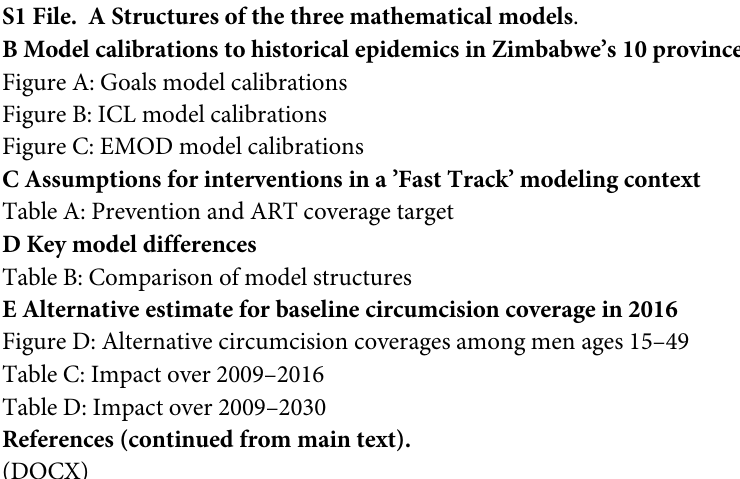
Figure B: ICL model calibrations Figure C: EMOD model calibrations Table A: Prevention and ART coverage target Table B: Comparison of model structures E Alternative estimate for baseline circumcision coverage in 2016 Figure D: Alternative circumcision coverages among men ages 15–49 Table C: Impact over 2009–2016 Table D: Impact over